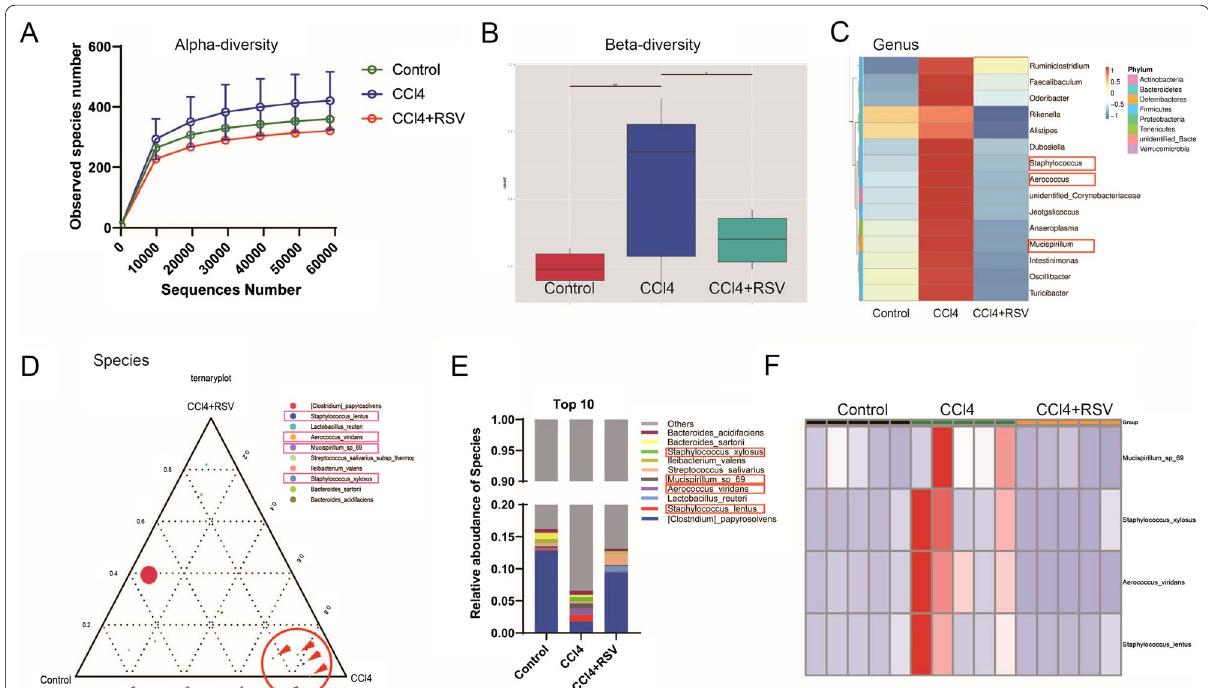
Fig. 2 Influence of resveratrol on gut microbiota in the progression of liver fibrosis in mice. Balb/c male mice (6–7 weeks old) were intraperitoneally injected with olive oil or CCl 4 (0.5 µL/g) to induce liver fibrosis for 4 weeks twice a week, and the mice were treated with 30 mg/kg resveratrol daily by gavage. Feces were collected for 16S rRNA sequencing in the fourth week. A , B The diversity and composition of microbial communities were evaluated using alpha-diversity and beta-diversity analysis, one-way ANOVA with Tukey’s post-hoc. C Genus analysis. D , E The dominant bacterial communities were assessed using Ternaryplot analysis and Top Ten abundance on species. F Analysis of the relative abundance of species, Z-score. * P < 0.05, ** P < 0.01 vs. Control or CCl 4 . Data are presented of three independent